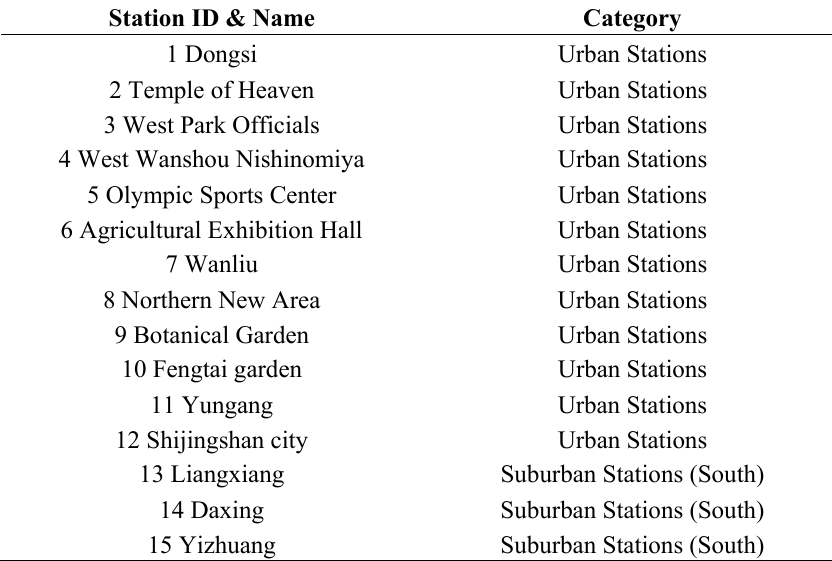
Figure 1. Distribution and station IDs of the 35 air quality monitoring stations. The four rings in the map are the 2nd, 3rd, 4th, and 5th Ring Road in Beijing from inner to outside. The 12 urban stations were deployed in the urban areas of Beijing, while the 11 suburban stations were located at the downtown areas of suburban counties in Beijing. The seven background stations were placed at those areas far away from human activities: Station 24 is the background for urban areas; Stations 25 and 26 are for monitoring the transportation from north and northwest directions; Stations 27 and 28 in the northeast and southeast mainly monitored the transportation from nearby Tianjin; Stations 29 and 30 in the south and southwest were for monitoring the data from the heavily polluted Hebei Province. Different to the previous 30 stations, the five traffic monitoring stations were placed just next to the main road as suggested in Table 1, while the other 30 stations were 150 m away from the main road according to NAAQS-2012. Table 1. Category and locations of monitoring